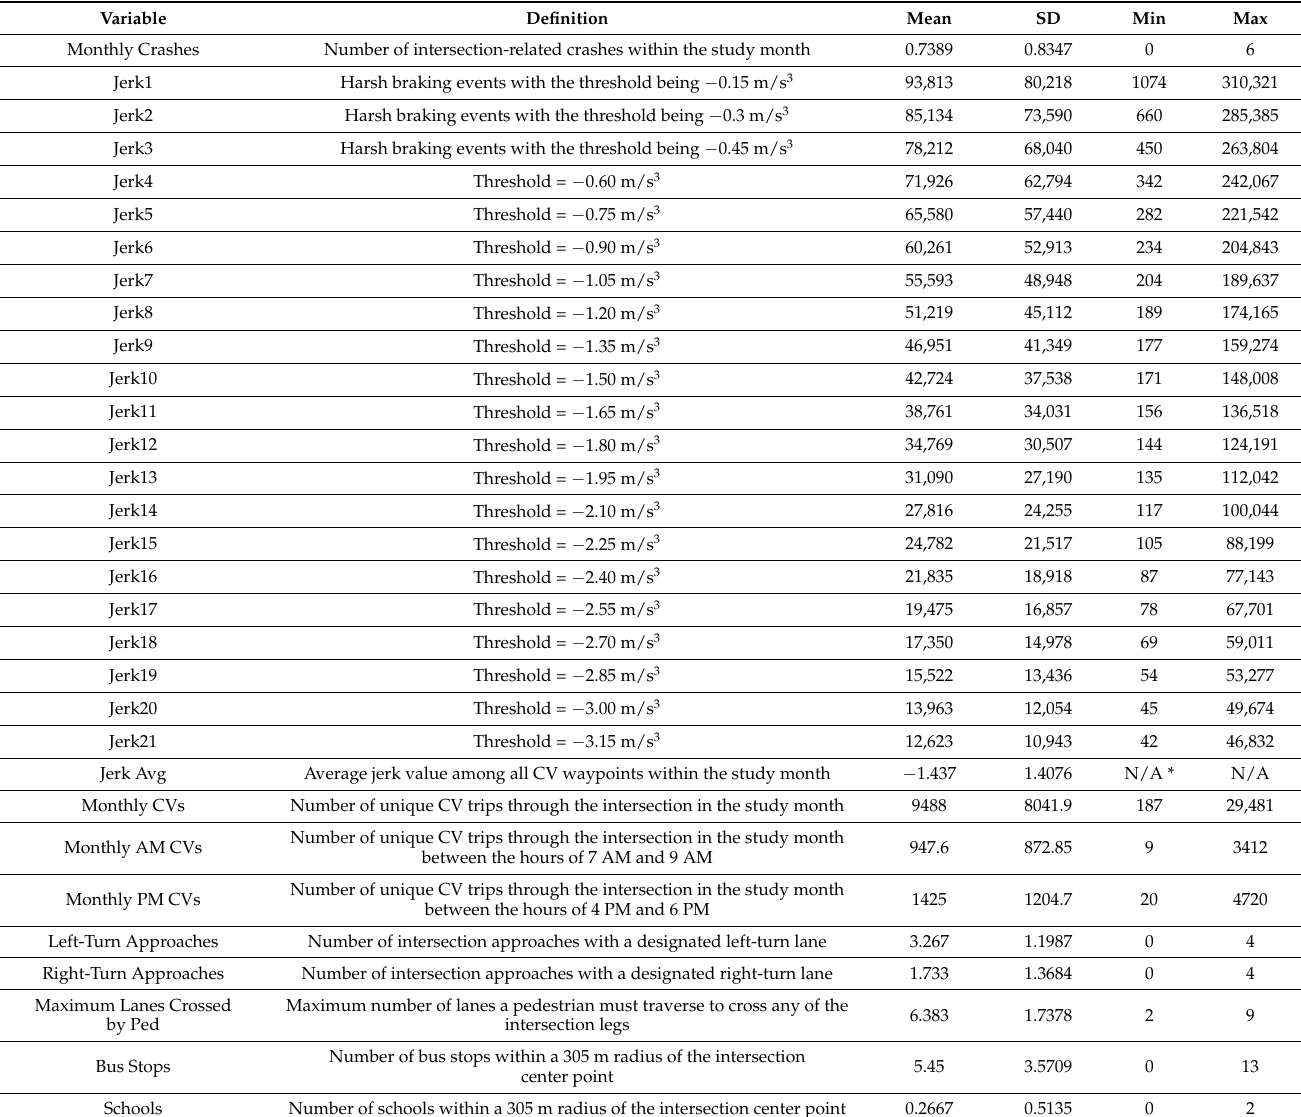
Table 1. Summary of